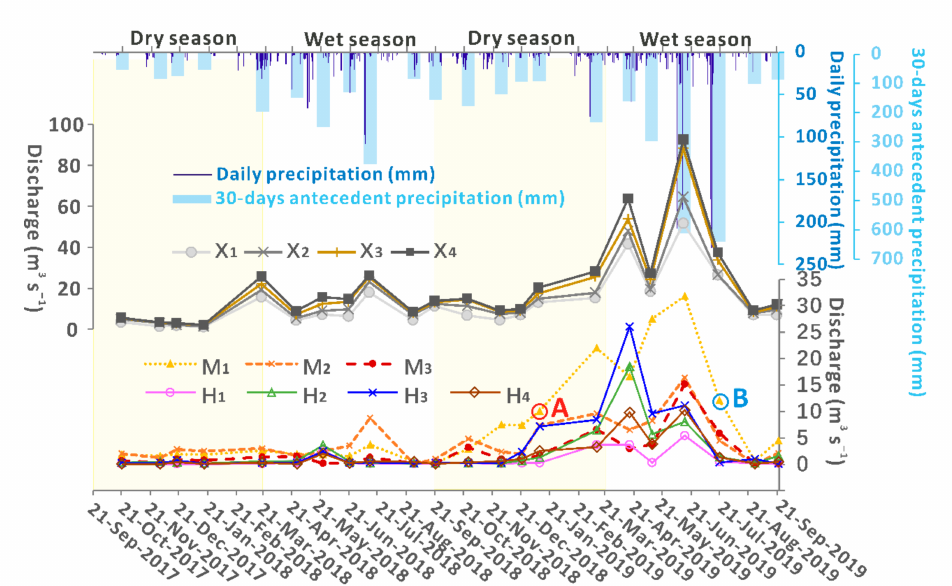
Figure 2. The time series of discharge at the eleven monitoring sections, the daily precipitation and the 30-days antecedent precipitation (referred to the total amount of precipitation over the last 30 days). The light-yellow area represents the dry season. The observation A after rain events in the dry season and observation B during low-flow period in the wet season had similar flow